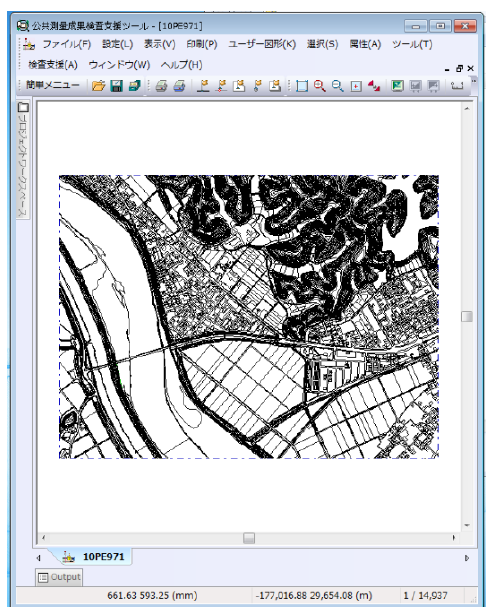
Figure 4. Digital Base Map at a scale of 2500 for reconstruction